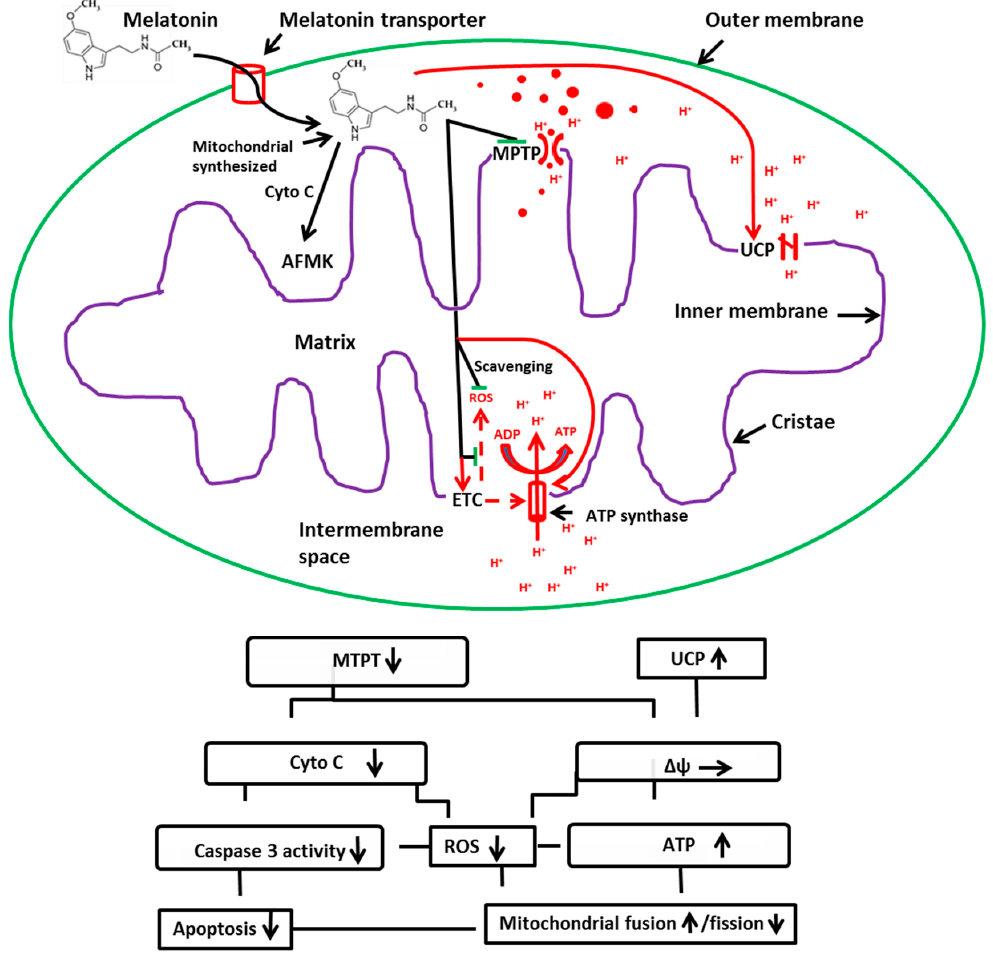
Figure 4. A summary of the potential effects of melatonin on a mitochondrion. MPTP: mitochondrial permeability transition pore; UCP: uncoupling protein; ROS: reactive oxygen species; ETC: electron transport chain; Cyto C: cytochrome C; AFMK: a melatonin metabolite, N 1 -acetyl- N 2 -fomyl-5- methoxykynuramine, which is also a potent antioxidant. Melatonin is metabolized to AFMK by cytochrome C via pseudo-enzymatic process [77]. Upper panel: The targeting sites of melatonin on mitochondrion; green lines: inhibition; red arrows: activation; red dash arrows: the directions of the multiple steps of reactions; black arrows: directions; Lower panel: Summary of the outcomes induced by melatonin’s action on mitochondrion; upward arrowhead: activation; downward arrowhead: inhibition; horizontal arrowhead: preservation; connecting lines indicate hierarches of the events. Conflicts of Interest: The authors declare no conflict of interest.